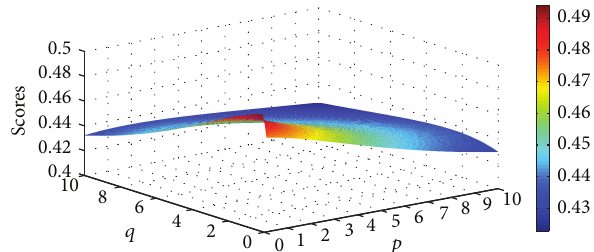
Figure 8: Scores for District 𝐴 4 obtained by the IIFGWHM operator ( 𝑝 ∈ (0,6], 𝑞 ∈ (0, 6]